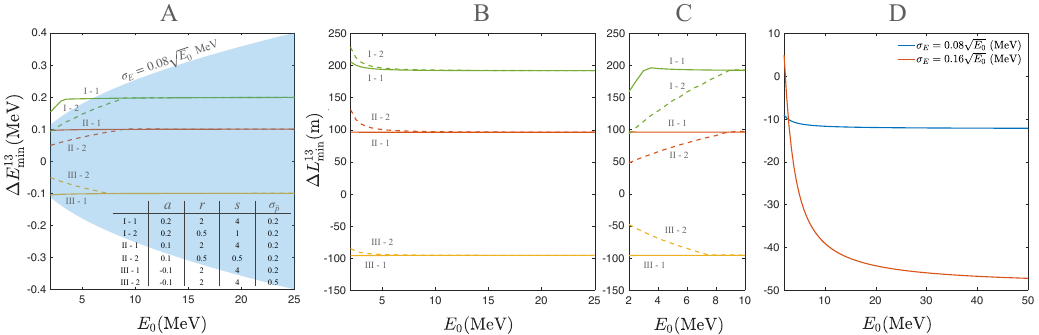
( L 13 ) for a number of quantum uncertainty min min